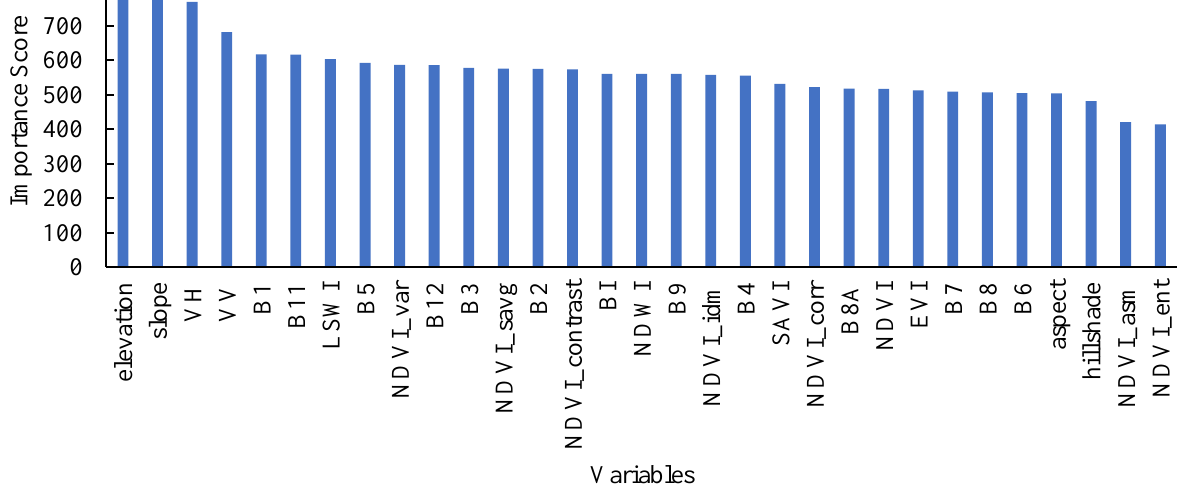
Figure 4. Distribution of the importance scores of the variables used in the RF classification algorithm.